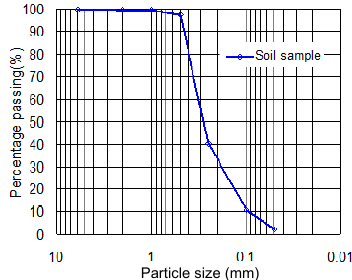
Figure1. Particle-size distribution curve ( Natural cohesion is 3.4 kPa, Phi is 32° compared to Figure 1. Particle-size distribution curve (Natural cohesion is 3.4 kPa, Phi is 32 ˝ compared to saturated saturated cohesion 0.1 kPa and Phi 28.4°; the natural and saturated densities are 1.83 and cohesion 0.1 kPa and Phi 28.4 ˝ ; the natural and saturated densities are 1.83 and 2.05 g/cm 3 ). 2.05 g/cm 3 ).